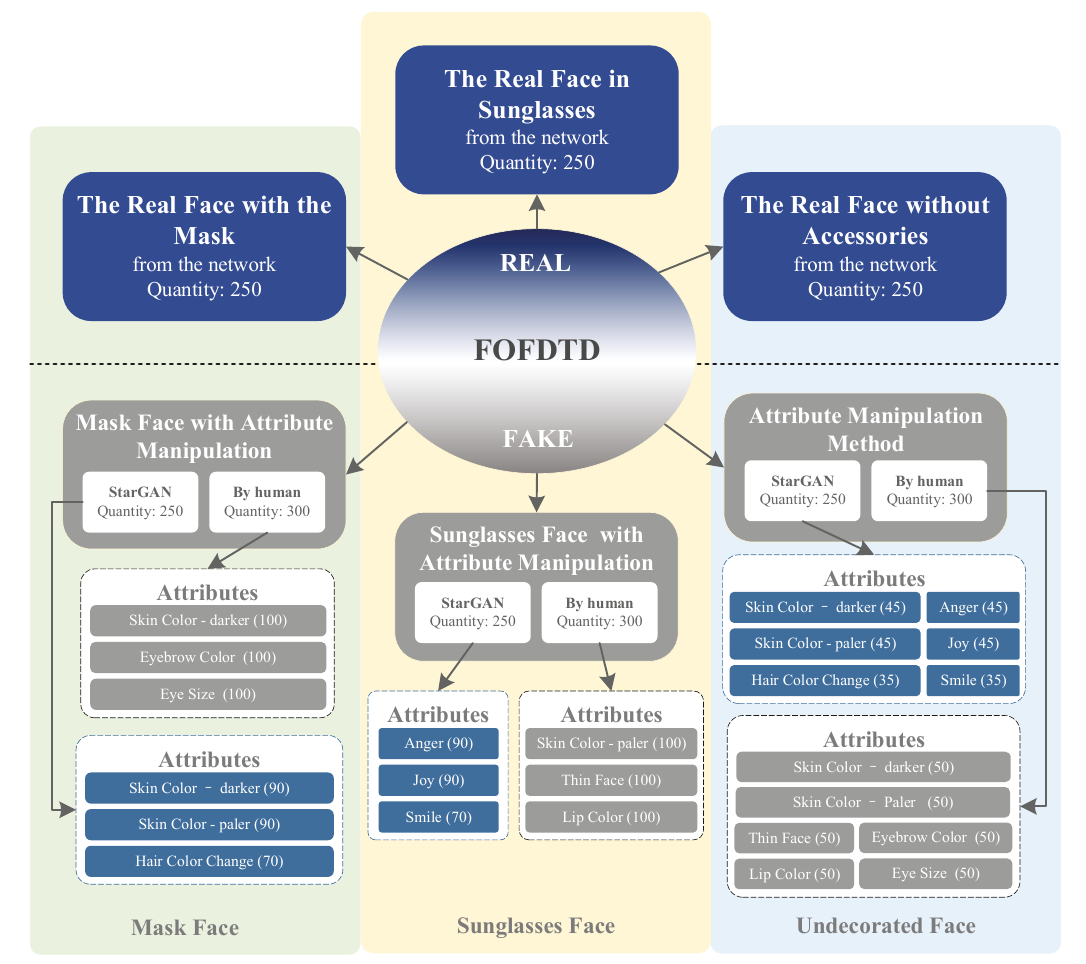
Figure 2. Overview of Focal-Organ Fake-Detection Test Dataset (FOFDTD).